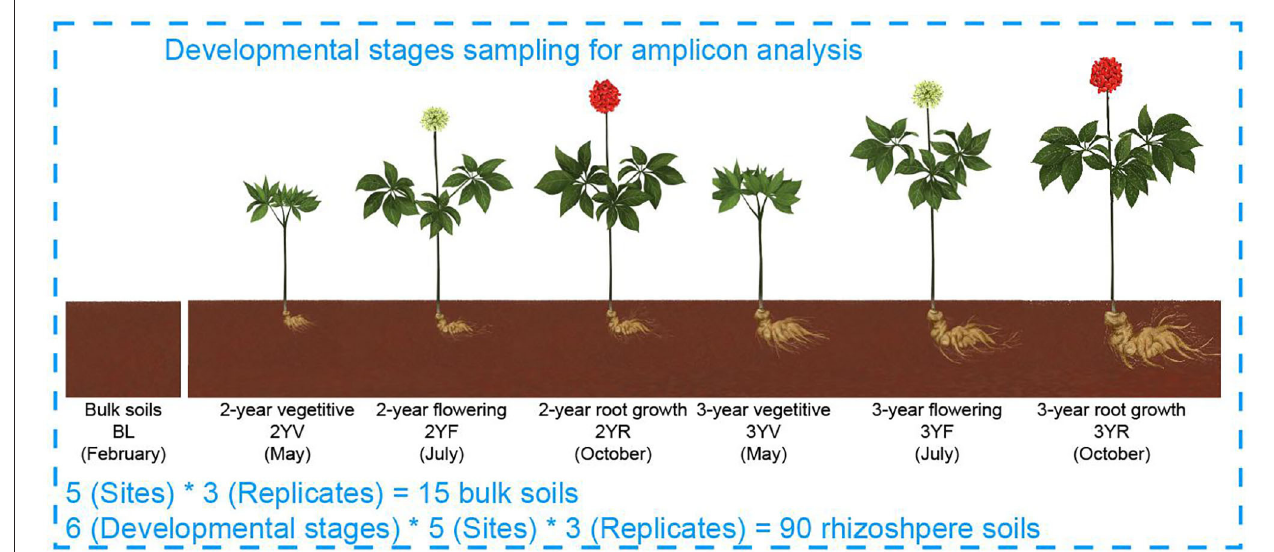
FIGURE 1 | Model of experimental samples collection. BLs were collected from farmlands before Panax notoginseng ( P. notoginseng ) transplanting. Rhizosphere soil samples were collected from P. notoginseng